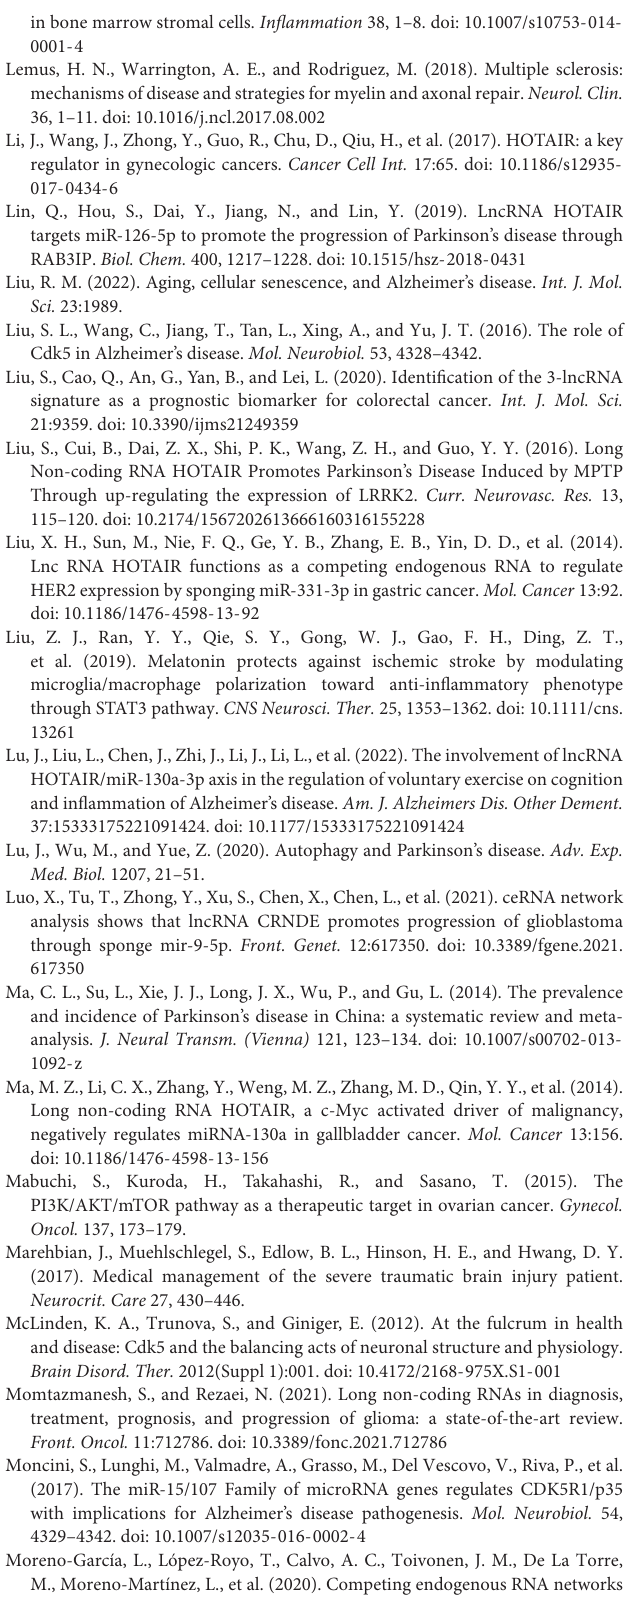
Frontiers in Molecular Neuroscience |